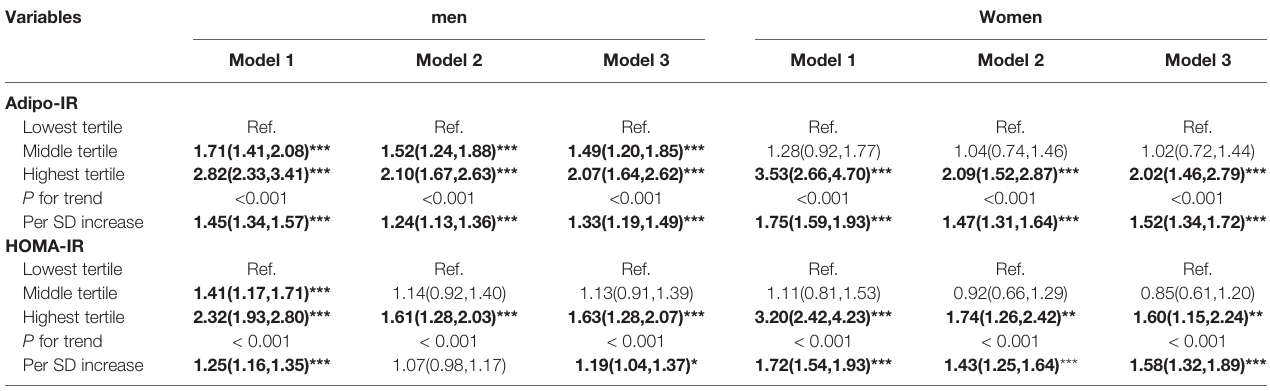
TABLE 3 | Logistic regression analysis for association between Adipo-IR or HOMA-IR and